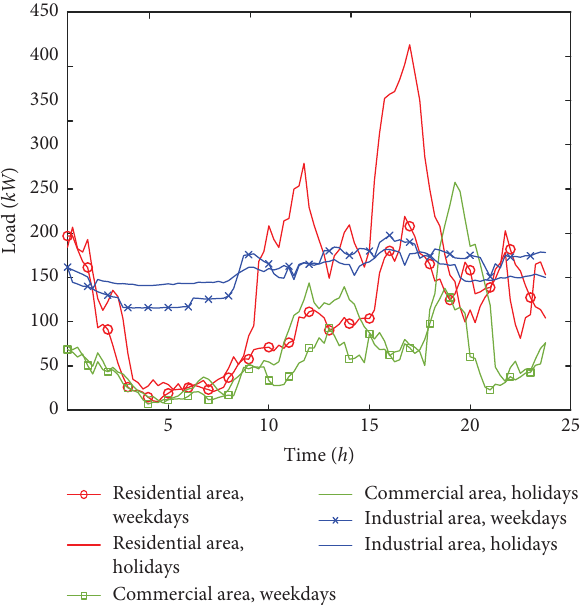
Figure 3: EV charging station load curves for diferent functional areas and